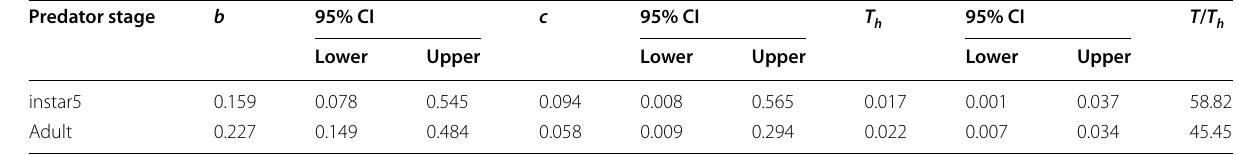
a In the best fit type III model, a